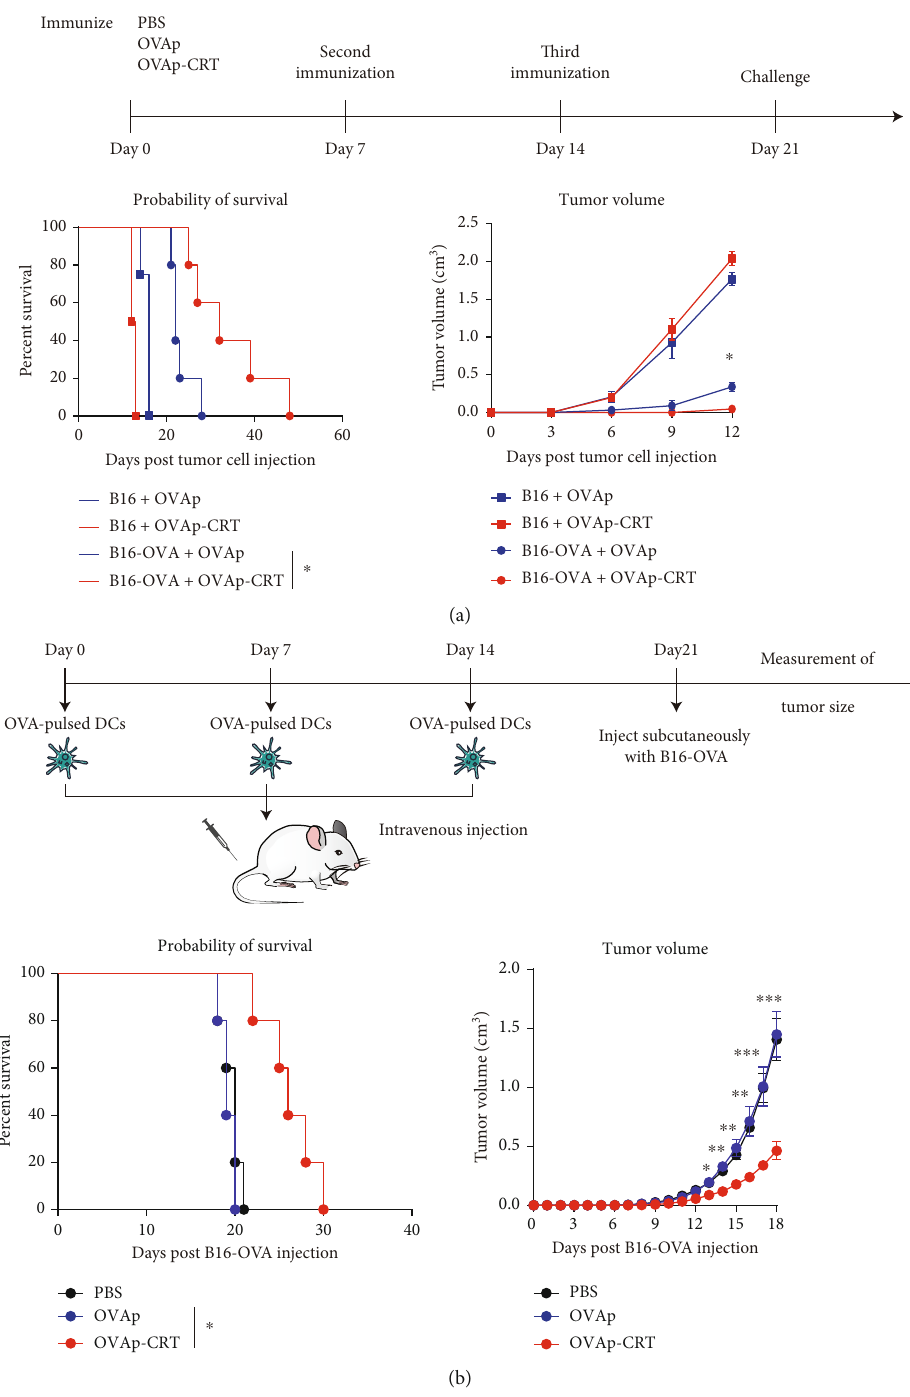
Figure 4: Immunization with OVAp- or OVAp-CRT-pulsed DCs protects mice from challenge with B16-OVA tumor cells. (a) Mice were immunized with OVAp or OVAp-CRT on days 0, 7, and 14. Seven days after the fi nal immunization, the mice were challenged by subcutaneous injection with 1 × 10 6 control or OVA-transgenic B16 tumor cells (B16 and B16-OVA, respectively). Following B16-OVA or B16 cell inoculation, mouse survival was recorded. Tumor growth was monitored by measuring the tumor diameter every 3 days and recorded as the average tumor diameter. (b) DCs were stimulated with OVAp or OVAp-CRT. Mice were adoptively transferred with OVAp- or OVAp-CRT-pulsed DCs on days 0, 7, and 14. Seven days after the fi nal immunization, the mice were challenged subcutaneously with 1 × 10 6 B16-OVA tumor cells. Following B16-OVA tumor inoculation, mouse survival was recorded. Tumor growth was monitored by measuring the tumor diameter every 3 days and recorded as the average tumor diameter. n = 5 mice per group. Data are representative of at least three independent experiments. ∗ p < 0 : 05 . ∗∗ p < 0 : 01 . ∗∗∗ p < 0 : 001